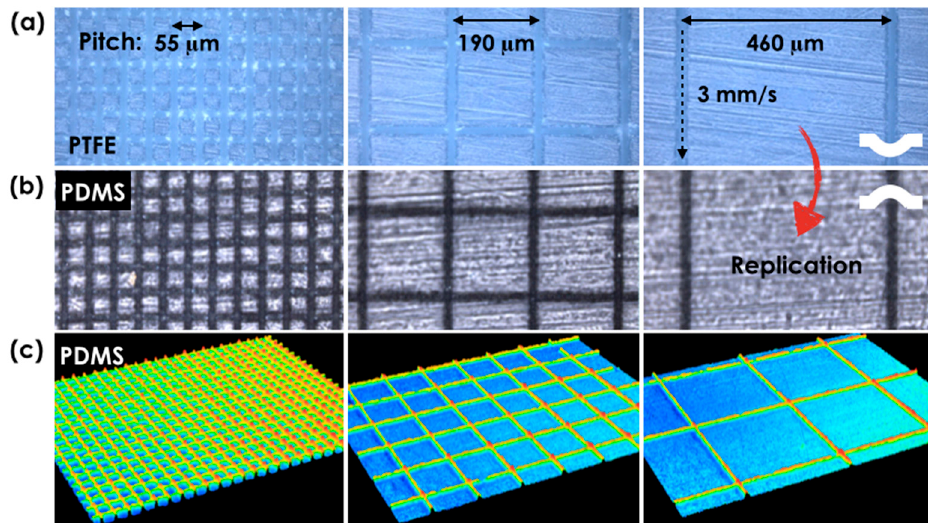
Figure 3. Direct PTFE surface morphology modification and PDMS replica: Microscopic pictures of ( a ) PTFE surface and ( b ) PDMS replica with varied pitches of 55, 190, and 460 μ m, at the scanning speed of 3 mm/s. The white schematics describe the surface morphology; ( c ) Confocal microscopic pictures of PDMS replica with varied pitches of 55, 190, and 460 μ m, at the scanning speed of 1 mm/s.